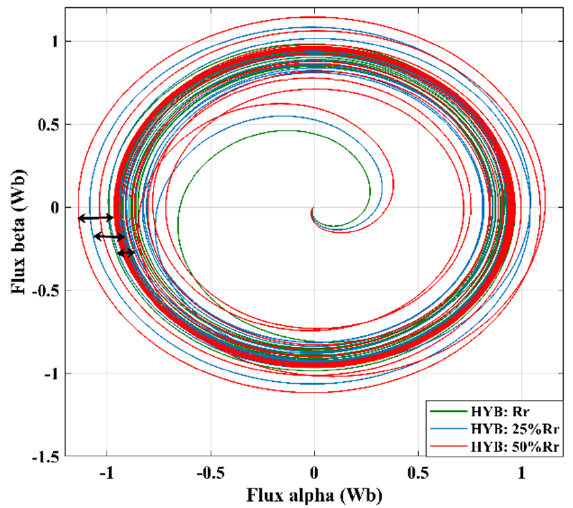
Figure 12. Alpha-beta rotor flux response against rotor resistance variation.